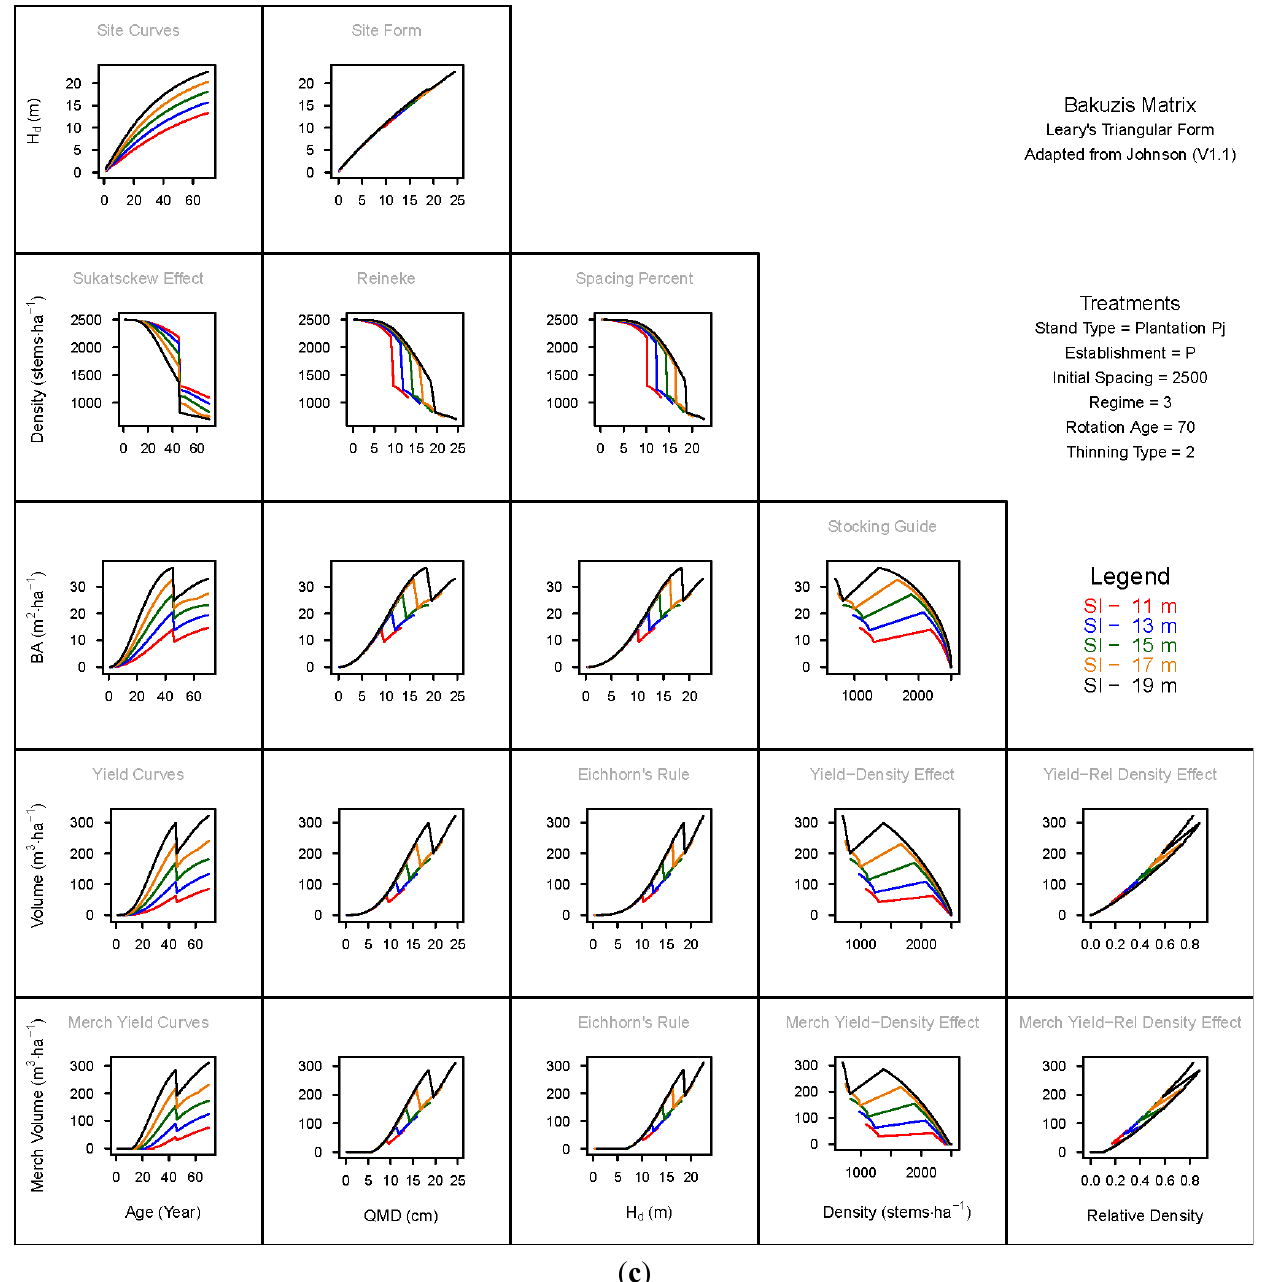
Figure A3. Bakuzis matrices for genetically-improved unthinned and commercially thinned (CT) jack pine (Pj) plantations (P) which were established at an initial densities of 2500 stems/ha and grown on 5 site qualities (SI) over 70 year rotations: ( a ) Regime 1 represented unthinned plantations in which genetic worth effects were described by the Type 1 response model; ( b ) Regime 2 was initially identical to Regime 1 and employed the same response model, however, the plantations were subjected to a single CT treatment at a stand age of 45 years in which the basal areas were reduced by 35%; and ( c ) Regime 3 was identical to Regime 2 but used the Type 2 response model to account for genetic worth